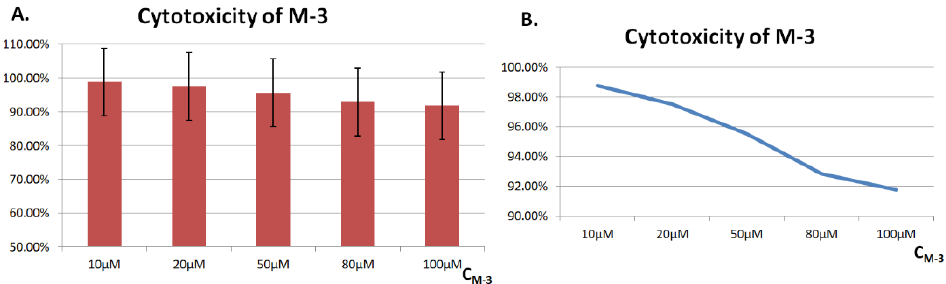
Figure 6. Cytotoxicity in HSC cells. ( A ) Histogram of the cytotoxicity in HSC cells; ( B ) Line trend chart of the cytotoxicity in HSC cells.